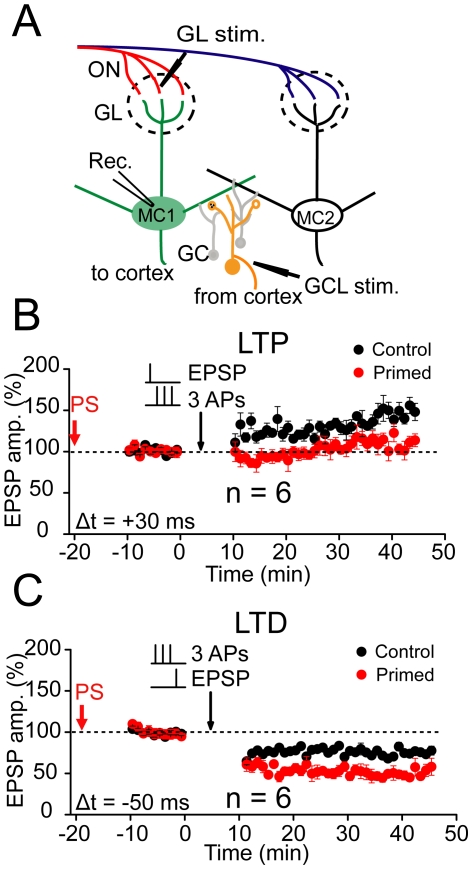
Regulation of STDP by prior TBS of proximal inputs at the GCL.(A) Schematic of experimental configuration. Bipolar stimulation electrodes were placed at a correlated glomerulus (upper dotted line circle) and GCL to activate presynaptic excitatory sensory inputs to MCs and proximal inputs to GCs, respectively. (B) PS of proximal inputs at the GCL suppressed LTP by decreasing the magnitude of potentiation (n = 6; p<0.001). The potentiation of EPSPs in MCs was induced with a +30 ms pairing protocol. The stable EPSP baseline recording was performed 10 min after the end of the previous TBS. (C) Prior TBS of proximal inputs at the GCL facilitated LTD by increasing the magnitude of depression (n = 6; p<0.001). The control data in B and C are the same as in Fig. 3C and G, respectively.